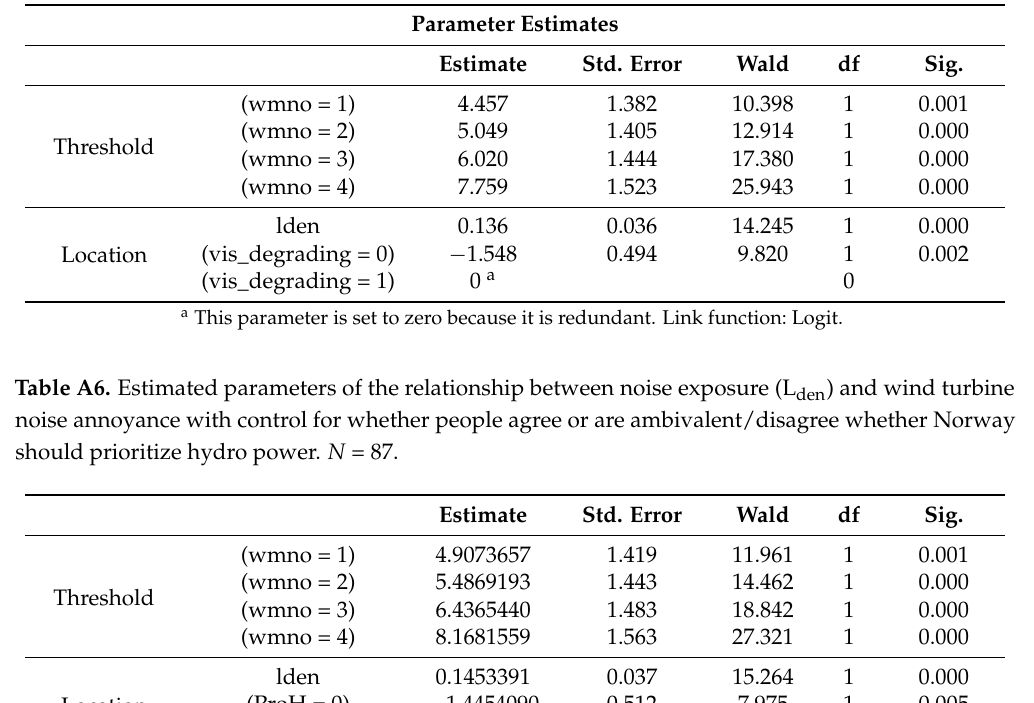
Table A5. Estimated parameters of the relationship between noise exposure (L den ) and wind turbine noise annoyance with control for whether windmills are perceived as visually degrading (in general, or at site location). N = 86.